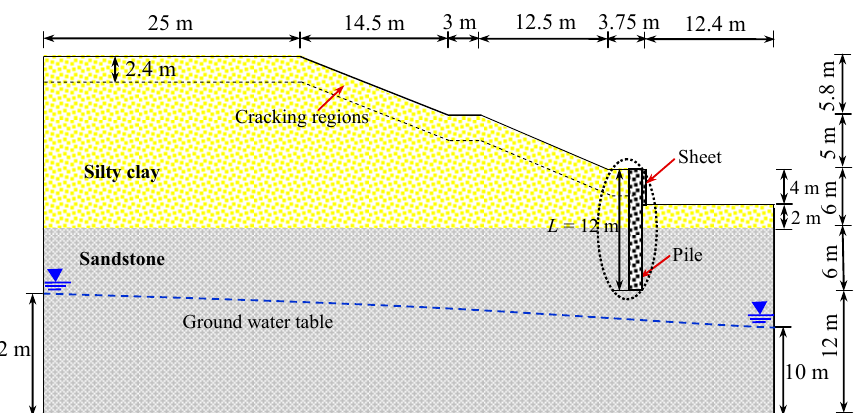
Figure 17. Cross-section of soil slope with cracking regions.